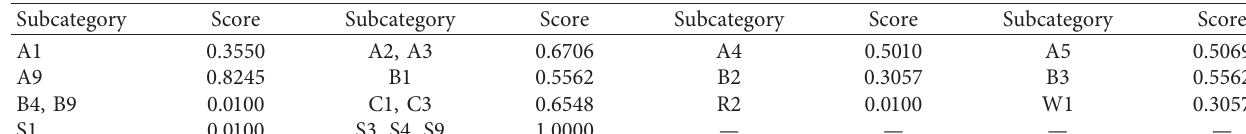
Table 3: Public awareness scores of POI